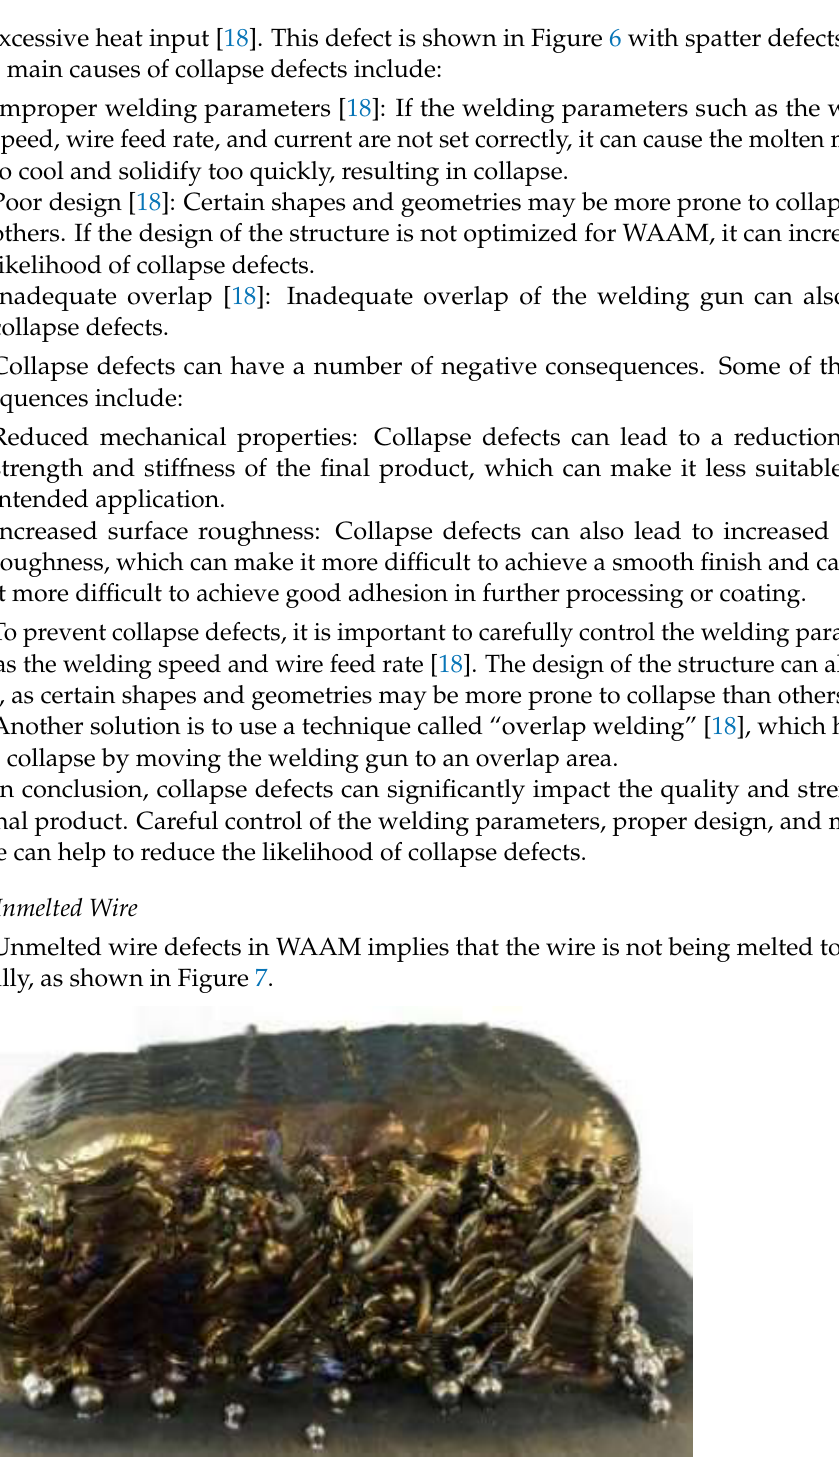
Figure 7. Unmelted wire in WAAM, adapted from [18].